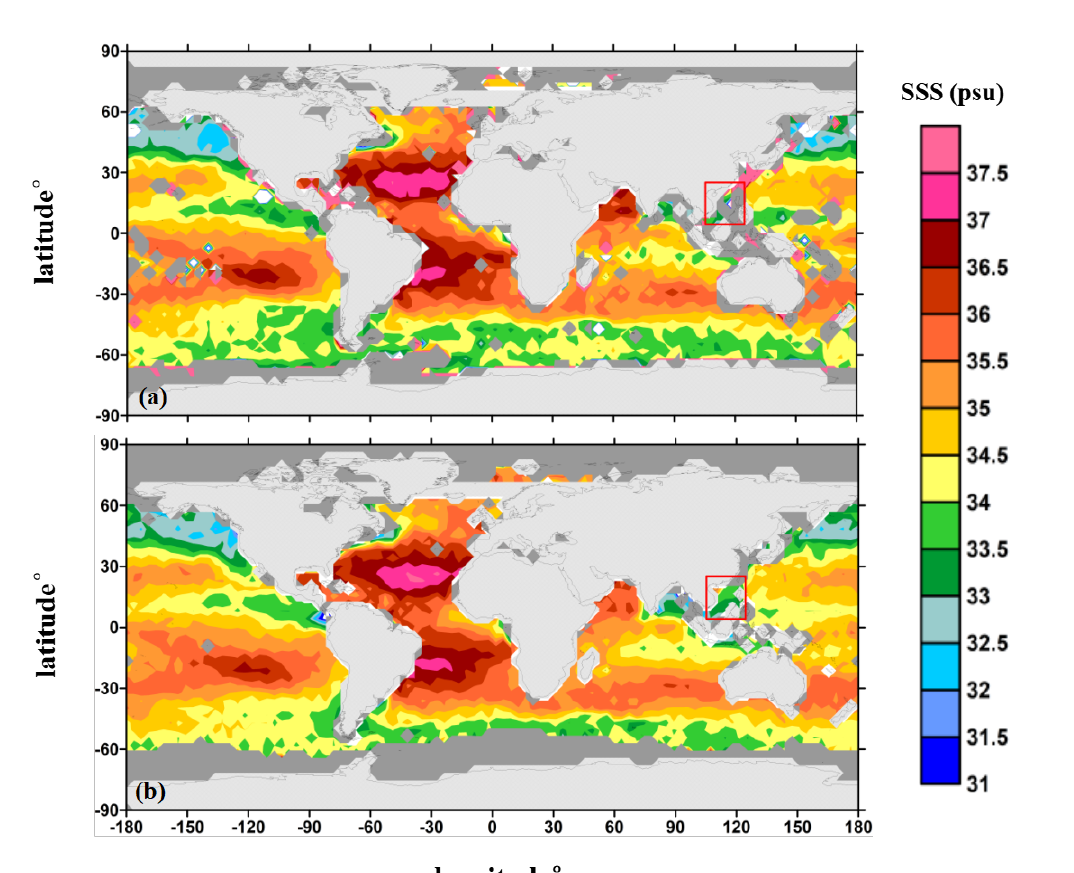
Figure 2. Level 3 SSS global products. Insufficient data for ocean salinity retrieval leaves gaps represented by dark gray; SSS global products provided by two reprocessed teams ( a ) CATDS— Centre Aval de Traitement des Données SMOS, France. ( b ) BEC—Barcelona Expert Center, Spain. SCS region is marked by the red